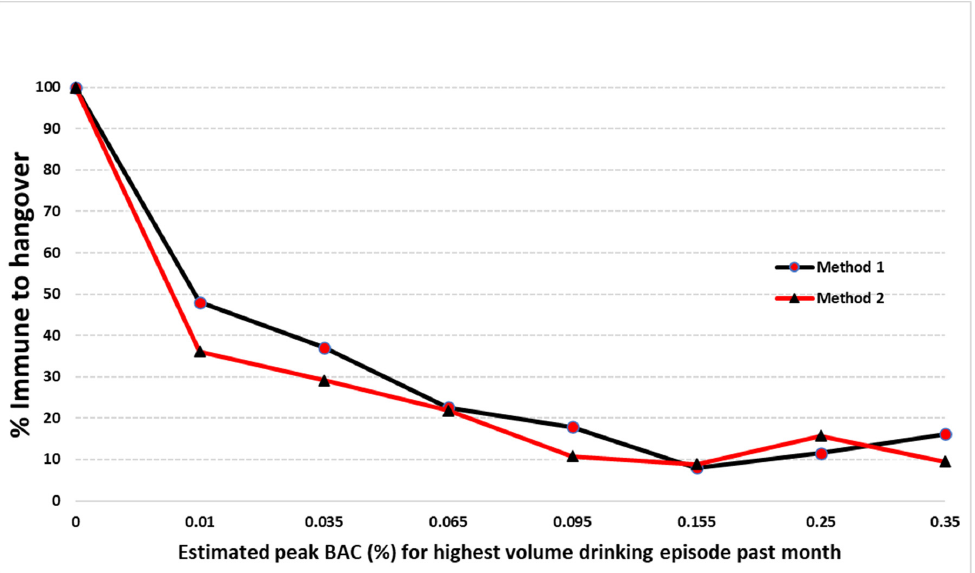
Figure 1. Prevalence of hangover resistance after alcohol consumption at different eBAC levels for Method 1 [26] and Method 2 [44] . * p < 0.05 with Chi Square test of independence.